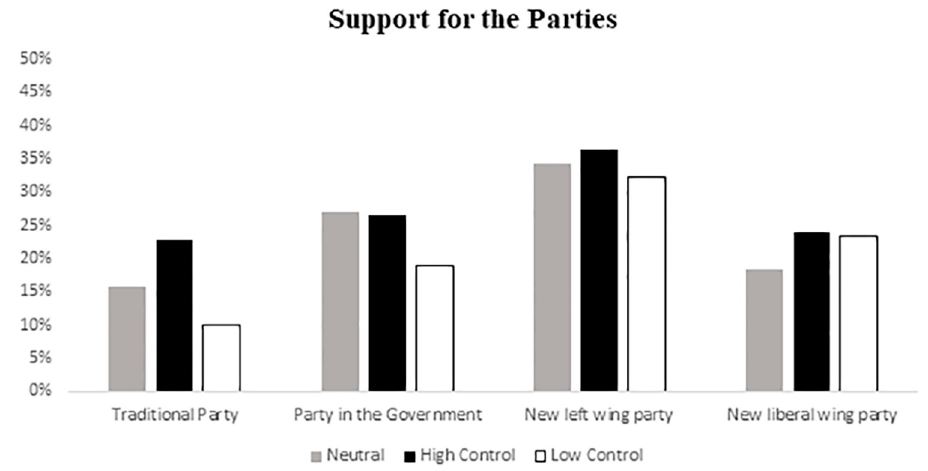
Fig 1. Support for the different political parties by experimental conditions (Traditional party: